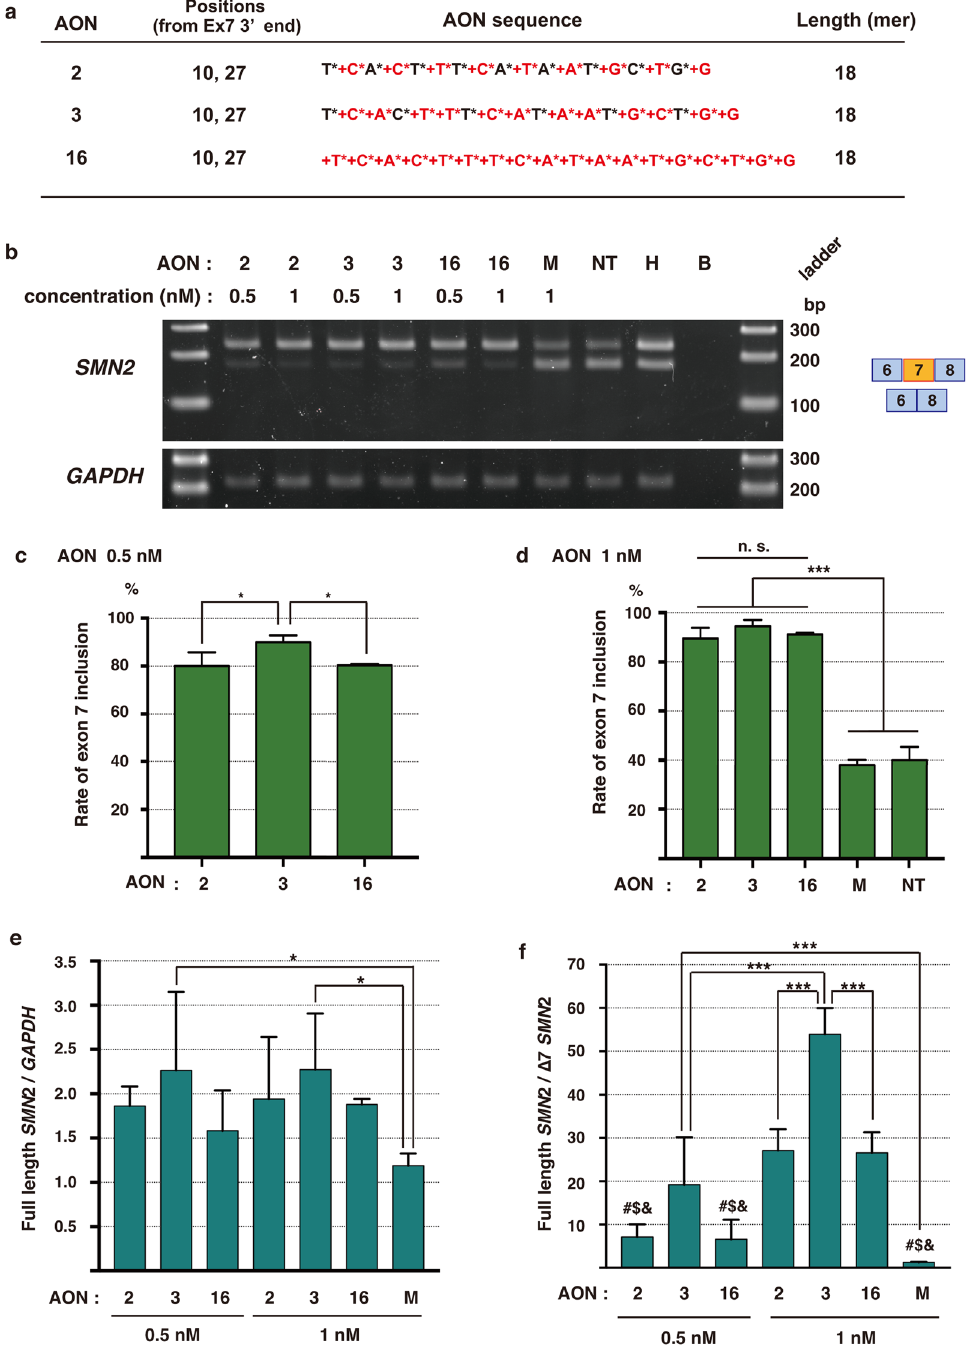
Figure 6. LNA-to-DNA replacement improves exon 7 inclusion activity. ( a ) AON sequences used for the experiment. AON #16 consists of 100% LNA. DNA base: G, A, T, C. LNA base (red): + G, + A, + T, + C. Phosphorothioated DNA base: G * , A * , T * , C * . Phosphorothioated LNA base (red): + G * , + A * , + T * , + C * . ( b ) RT-PCR of SMN2 and GAPDH in human SMA patient fibroblasts (GM03813). AONs were transfected at 0.5 or 1 nM concentration. Top band: exon 7-included. Bottom band: exon 7-excluded. ( c ) Quantification of SMN2 exon 7 inclusion in AON-treated SMA fibroblasts by RT-PCR. AONs were transfected at 0.5 nM concentration. * p < 0.05. ( d ) Quantification of SMN2 exon 7 inclusion in AON-treated SMA fibroblasts by RT-PCR. AONs were transfected at 1 nM concentration. *** p < 0.005. ( e ) Relative expression of full-length SMN2 to GAPDH measured by qPCR. The data was normalized to non-treated cells. * p < 0.05. ( f ) Relative expression of full- length SMN2 to ∆ 7 SMN2 measured by qPCR. The data were normalized to non-treated cells. *** p < 0.005. #$& Significant difference with AON #2, #3, and #16 (1 nM treatment, p < 0.005). Bars represent mean ± S.D. of three independent experiments. One-way ANOVA with a Tukey’s multiple comparison test. n.s.: not significant. M: mock control AON, NT: non-treated, H: healthy cells, B: